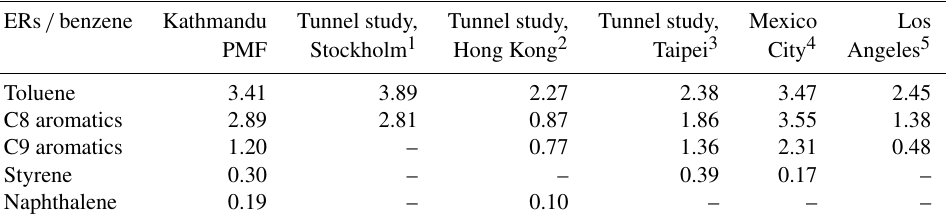
Table 4. Emission ratios of NMVOCs / benzene for aromatic hydrocarbons derived from the PMF model for factors attributed to traffic and comparison of ERs with previous studies for traffic source profiles.